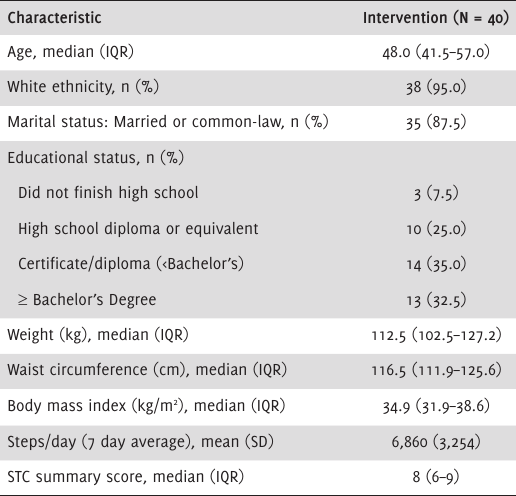
Table 1. Baseline Characteristics of Hockey FIT Intervention Group Figure 1. Distribution of Participants Across Intervention and Control Groups and Proportion of Inter-